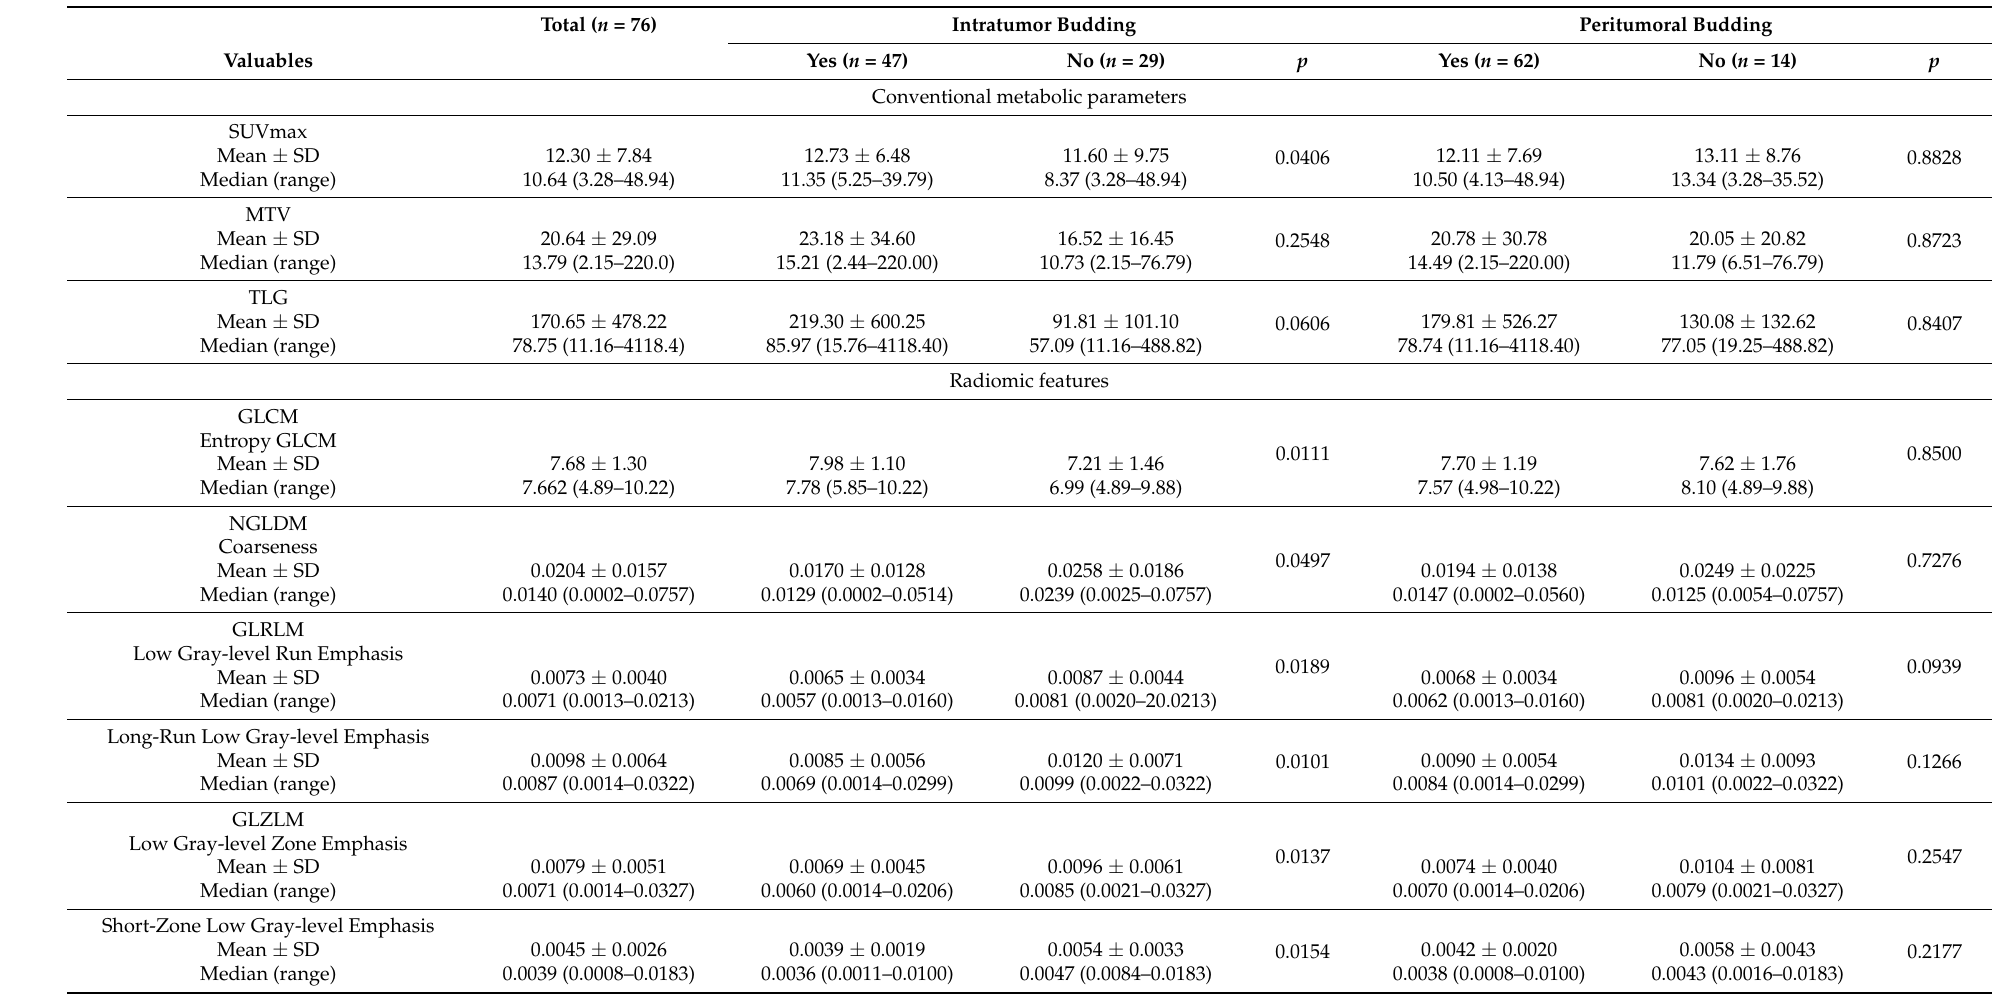
Table 2. Comparison of radiomic features according to the tumor budding